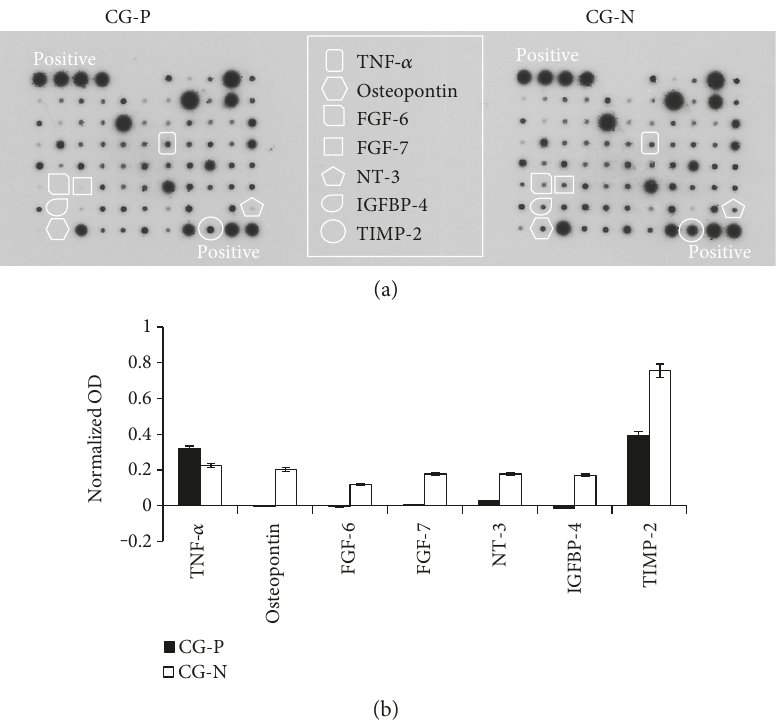
Figure 4: Screening of conditioned media from CG-N and CG-P CDCs for paracrine molecules. (a) Representative blots from protein arrays of CDC-conditioned media. A selection of growth factors, chemokines, and cytokines of interest is highlighted in the panel. Di ff erential analysis of conditioned media from CG-N and CG-P CDCs revealed a distinctive modulation in the secretion pro fi le of a subset of cytokines, as plotted in (b). OD: optical density; CG-N: normal cardiogel; CG-P: pathological